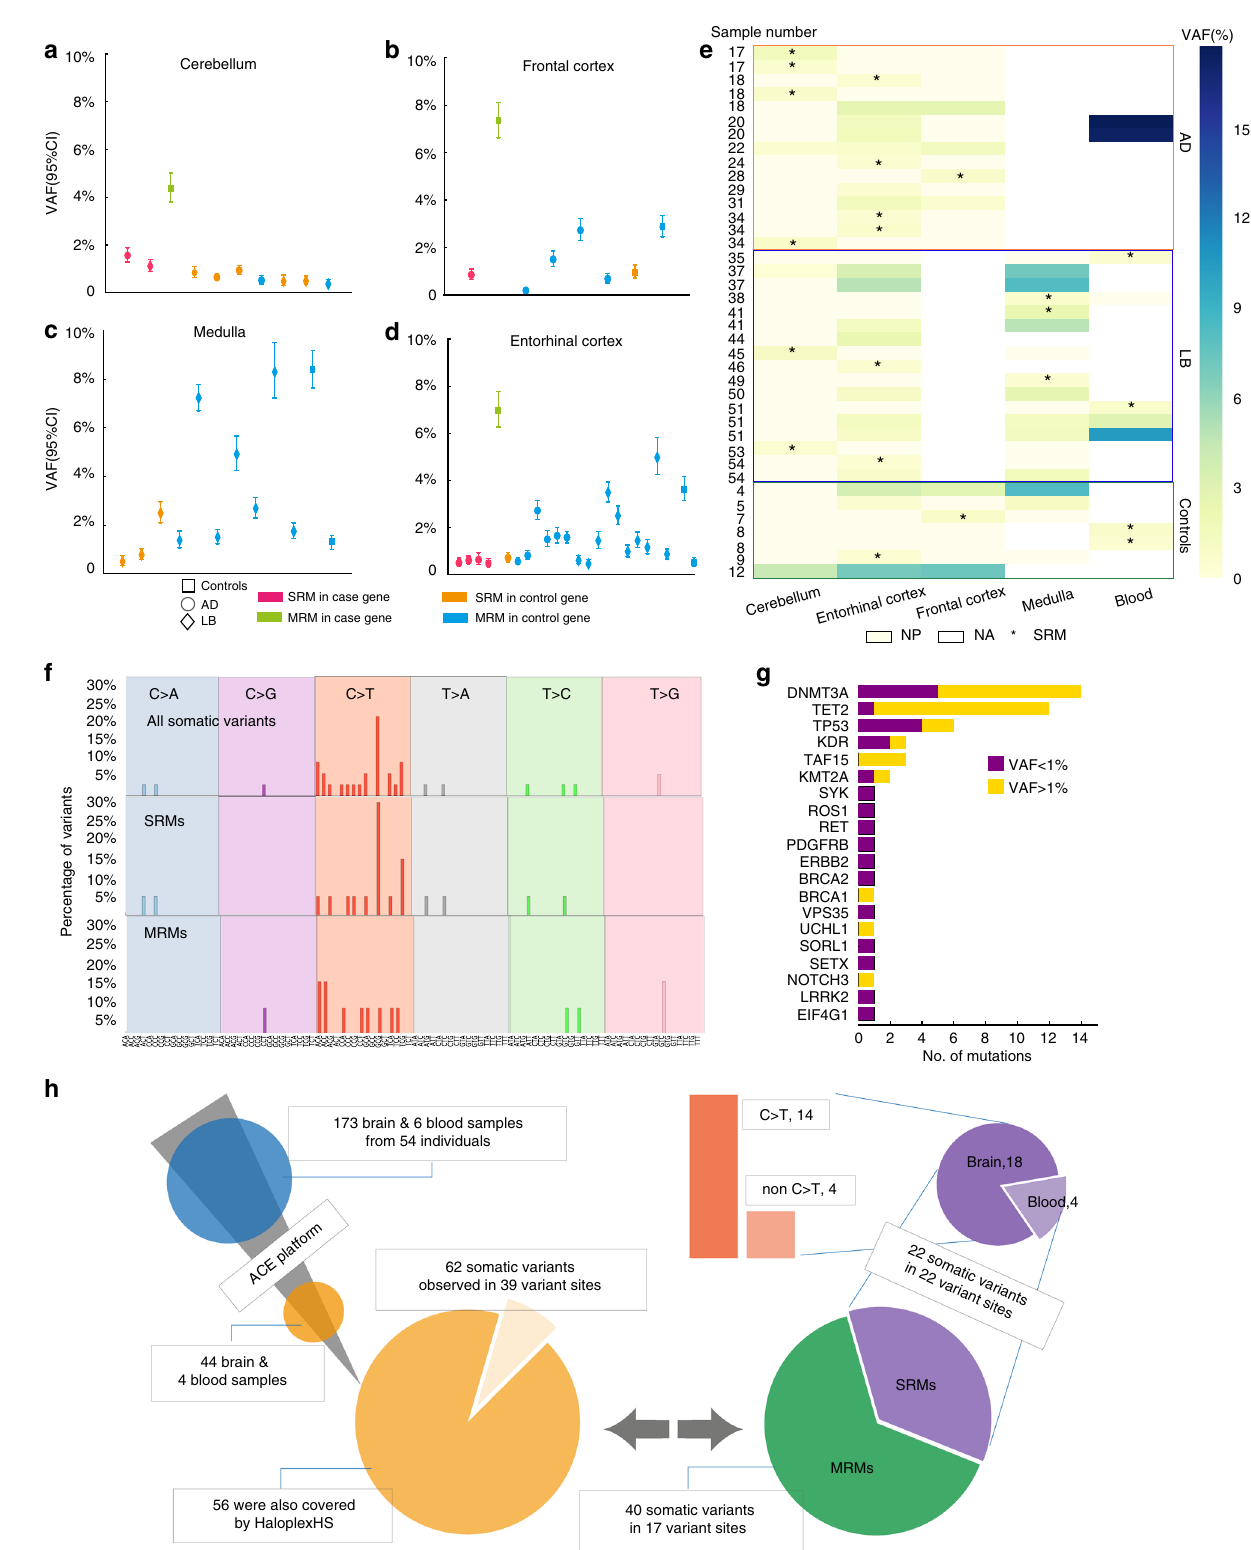
http://www.illumina.com/platinumgenomes/, and sequencing reads were processed using the same bioinformatic pipelines as described below. Duplicate HapMap dilution samples at 0.2, 0.5, 1, 2 and 5% VAF were called against a 0% ‘ pure ’ sample by MuTect2 8 , Varscan2 9,10 and deepSNV 11,12 . The sensitivity and speci fi city